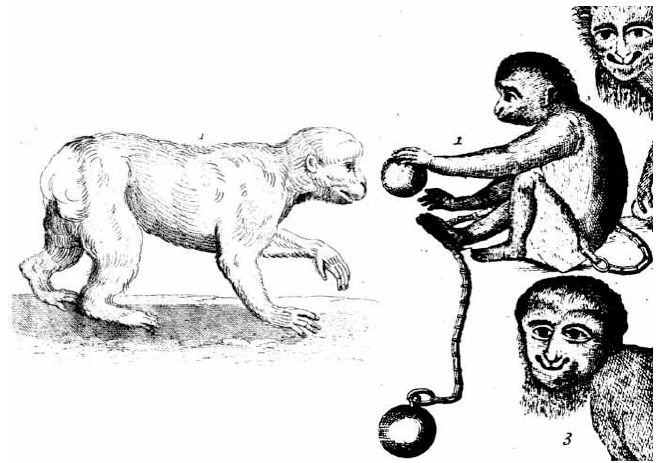
Figure 5. Engravings of the Barbary macaque by Alpini (1592). Historiae Aegypti Naturalis . Right side: the great cynocephalus , left side, the small cynocephalus (chained).